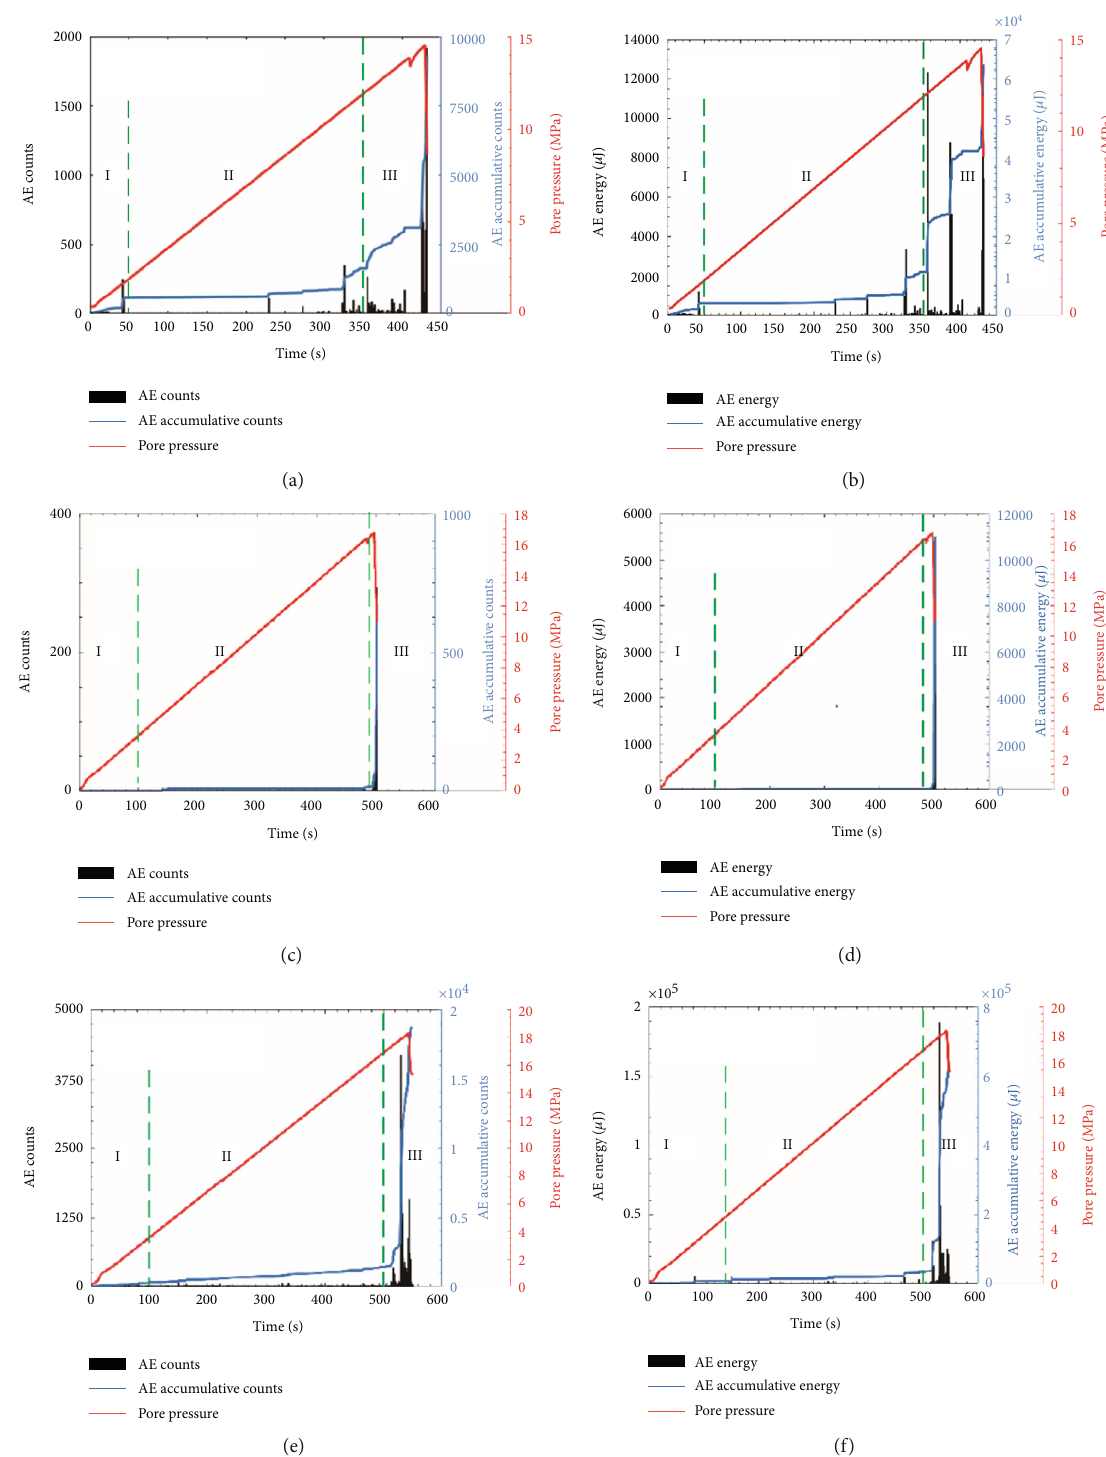
Figure 4: Plots of the relationship between the AE counts/accumulative counts, AE energy/accumulative energy, and loading pore pressures for the horizontal samples H1, H2, H3. (a, b) Plots of the sample H1. (c, d) Plots of the sample H2. (e, f) Plots of the sample H3. The green dashed lines roughly indicate the three stages (I: initial stage; II: quiet stage; and III: fracturing stage) of the fracturing